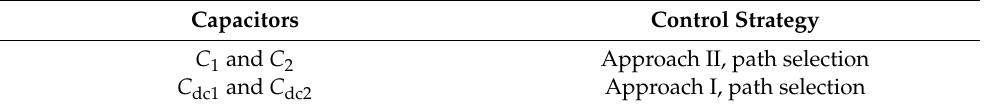
Table 2. Control strategies of the capacitor